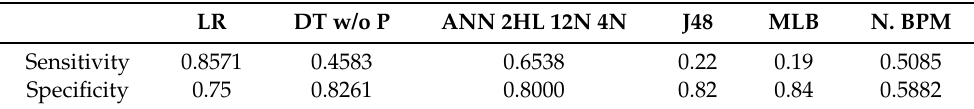
Table 5. Sensibility and Specificity